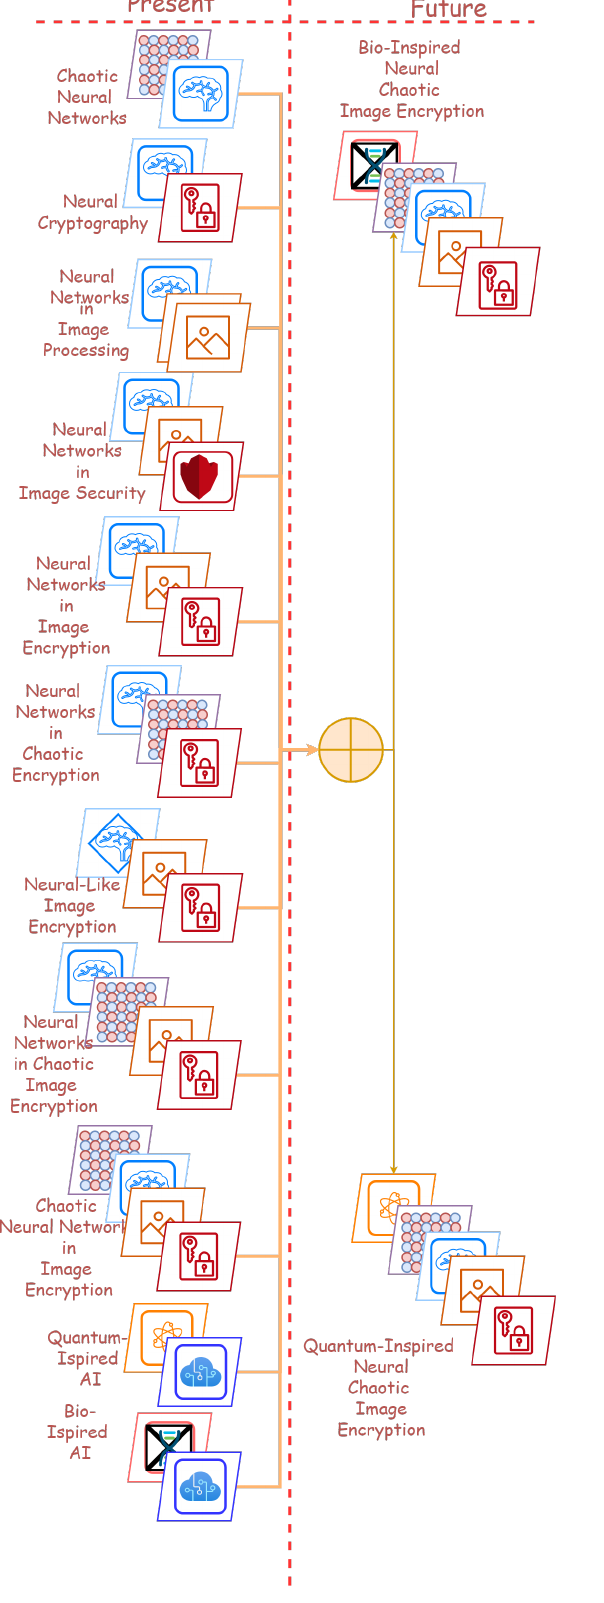
Figure 4. Chaotic Image Encryption Trends (Present and